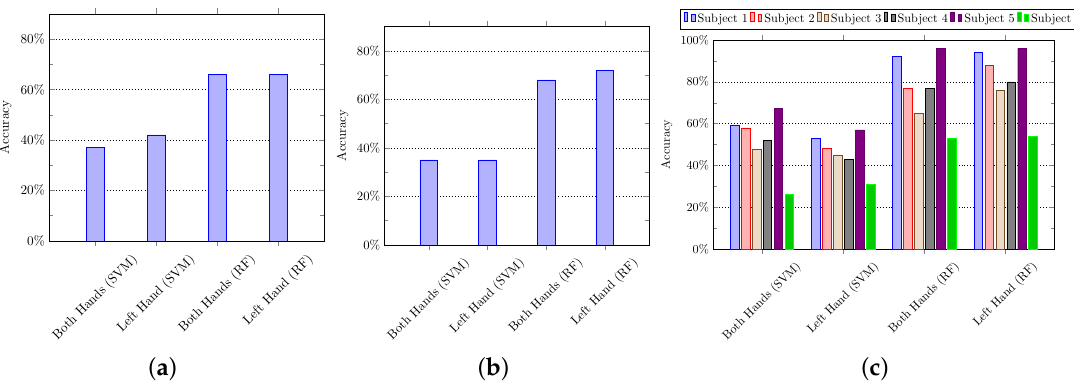
Figure 6. The composite activity recognition using handcrafted features with Support Vector Machine (SVM) and Random Forest (RF). ( a ) K -fold cross-validation, ( b ) hold-out cross-validation, and ( c ) leave-one-out cross-validation. In k -fold cross-validation, the training and testing data is split based on k folds. We set the value of k = 3. In hold-out cross-validation, the data of 3 subjects are used for training, and the data of the remaining 3 subjects is used for testing purposes, iteratively. In leave-one-out cross-validation, the data of 5 subjects are used for training, and the data of the remaining 1 subject is used for testing purposes,